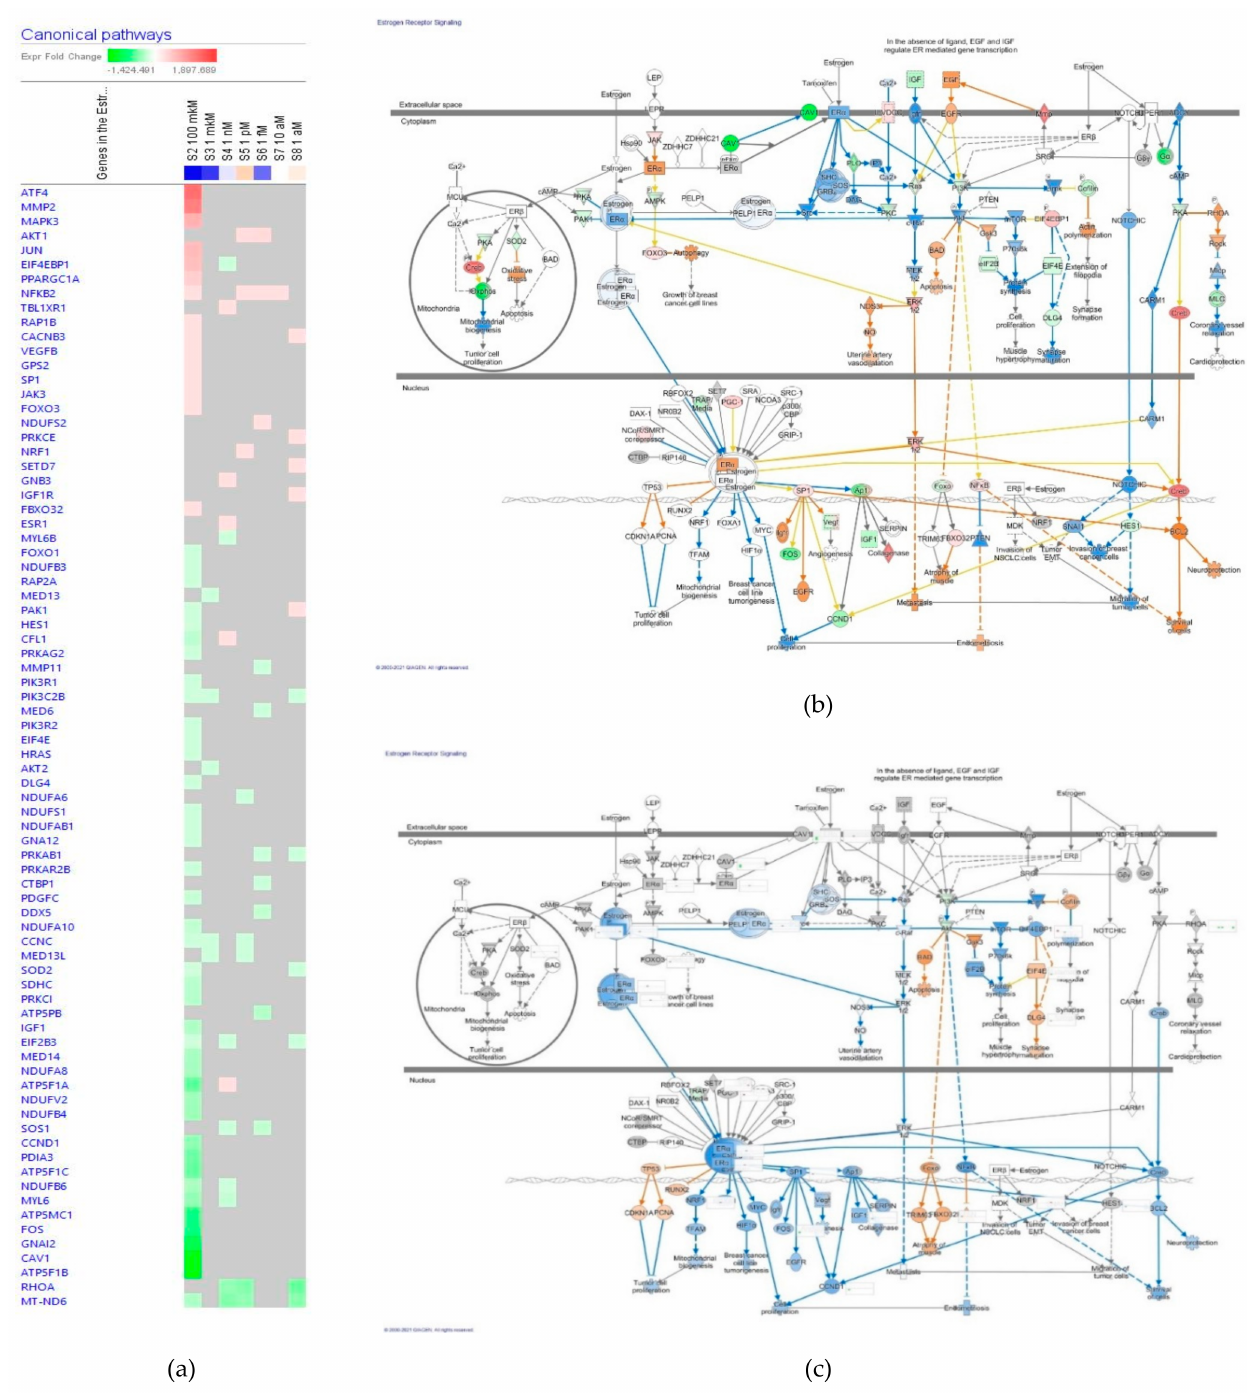
Figure 10. Effect of Rg5 on estrogen receptors signaling pathway: ( a ) Heatmap of gene expression (in fold changes compared to control, red, upregulation and green, downregulation), after exposure with ginsenoside Rg5 at different concentrations; the 100 µ M signature is shown in the leftmost column as solid red or green squares indicating genes that are upregulated downregulated, respectively; color intensity indicates the actual log-fold changes; ( b ) Rg5 in the concentration of 100 µ M— predicted inhibition (blue) and activation (brown); ( c ) Rg5 in the concentration of 1 µ M—predicted inhibition (blue) and activation